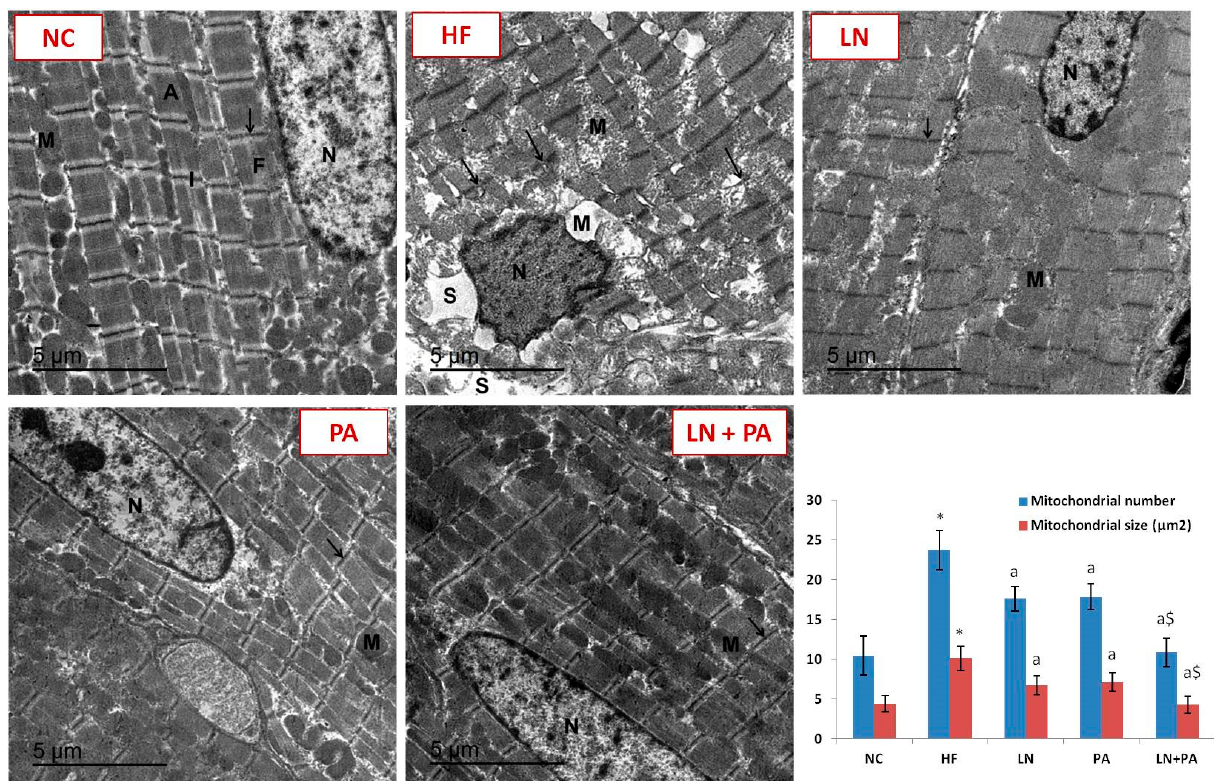
Figure 3. TEM photomicrograph of ultrathin sections in the left ventricular myocardium from different experimental groups. HF was induced with doxorubicin (3.5 mg/kg, i.p., twice weekly for 3 weeks) and rats were treated with PA (10 mg/kg), LN (10 mg/kg) and their combination (PA + LN) orally and daily for 4 weeks. Normal control rat (NC) showed a cardiomyocyte with a euchromatic nucleus. Myofibrils were seen with mitochondrial rows in-between them. Myofibrils presented with alternating light and dark bands. Z lines appeared as intersecting light bands. The left ventricular myocardium from rats in the HF group showed a dark nucleus and peripheral heterochromatin. Swollen mitochondria with ruptured cristae were detected in-between the fragmented myofibrils. Varied spaces between split myofibrils were noticed. The left ventricle from rats treated with LN and PA showed a cardiomyocyte with a heterochromatic nucleus. Some myofibrils were well structured, while others were disordered. Disordered mitochondria were noticed. Sections from the LN + PA group showed cardiomyocytes with a euchromatic nucleus with partial peripheral heterochromatin deposition. Cardiac myofibrils were observed with mitochondrial rows lying between them. Mitochondria were identified with their morphology. Their number and size ( µ m 2 ) were analyzed in 20 different random fields from each group, and data were presented as mean ± SD. * significant from NC at p < 0.001, a significant from HF at p < 0.001 and $ significant from both LN and PA at p < 0.05. Abbreviations: nucleus, N; mitochondria, M; myofibrils, F; Z lines, arrow; light bands, I; dark bands, A; space, S. Scale bar: 5 µ m. The intercalated discs in-between cardiac cells examined on the ultrastructural level are presented in Figure 4. NC rats showed well-ordered intercalated discs and glycogen particles in-between cardiac myofibrils. However, HF rats showed disordered intercalated discs between myofibrils. Some mitochondria were swollen with disturbed cristae and membrane. Increased spaces between cardiac myofibrils were also seen. HF rats treated with either LN or PA showed partially organized intercalated discs with swollen mitochon- dria. Rats that received combined LN and PA treatment showed near to normal intercalated discs and glycogen particles between